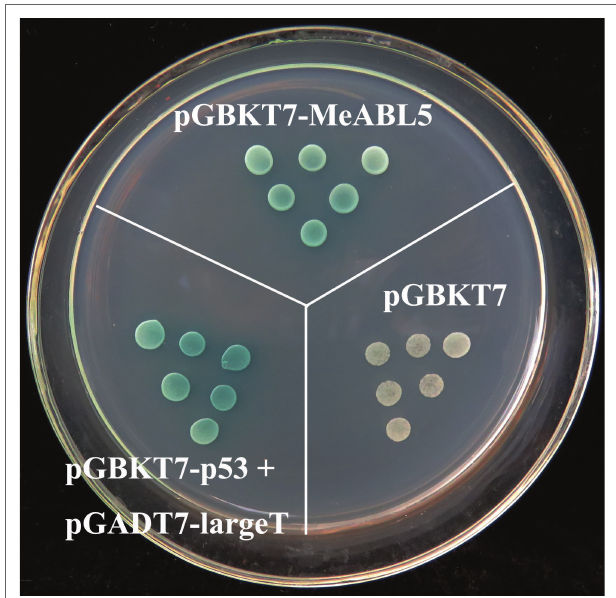
FIGURE 5 | The transactivation activity of the MeABL5 protein in yeast. MeABL5 was inserted into the pGBKT7 vector and transformed into the AH109 yeast strain. The empty vector, pGBKT7, and pGBKT7-p53 + pGADT7- largeT were also transformed into AH109 as a negative and positive control, respectively. The yeast cells were spotted on plates with SD/−Trp selective medium containing 10 mg/ml X- α -gal.